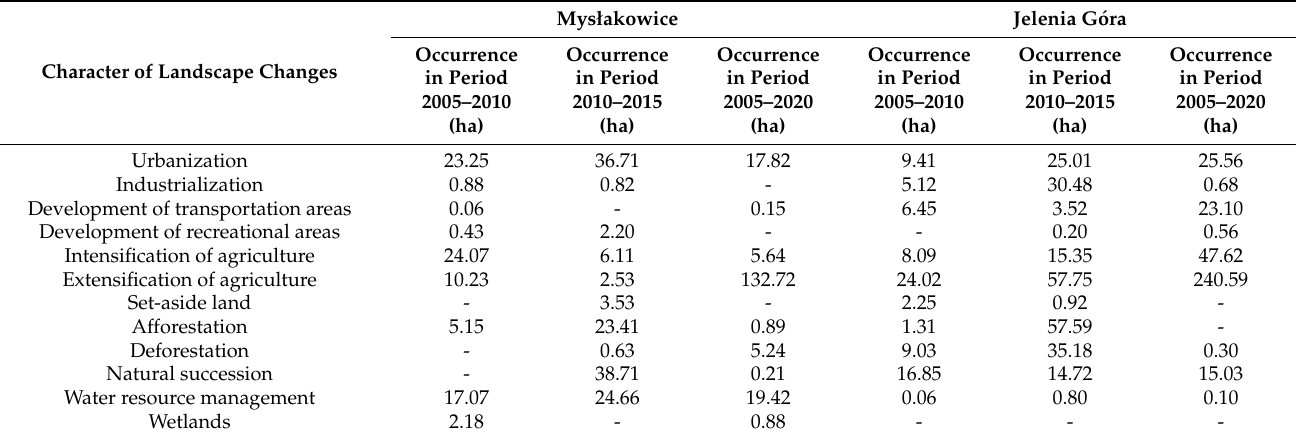
Figure 2. Five main types of driving forces in the communities. Table 3. Area of each character of landscape changes in different time periods in the Mysłakowice commune and the city of Jelenia Góra.